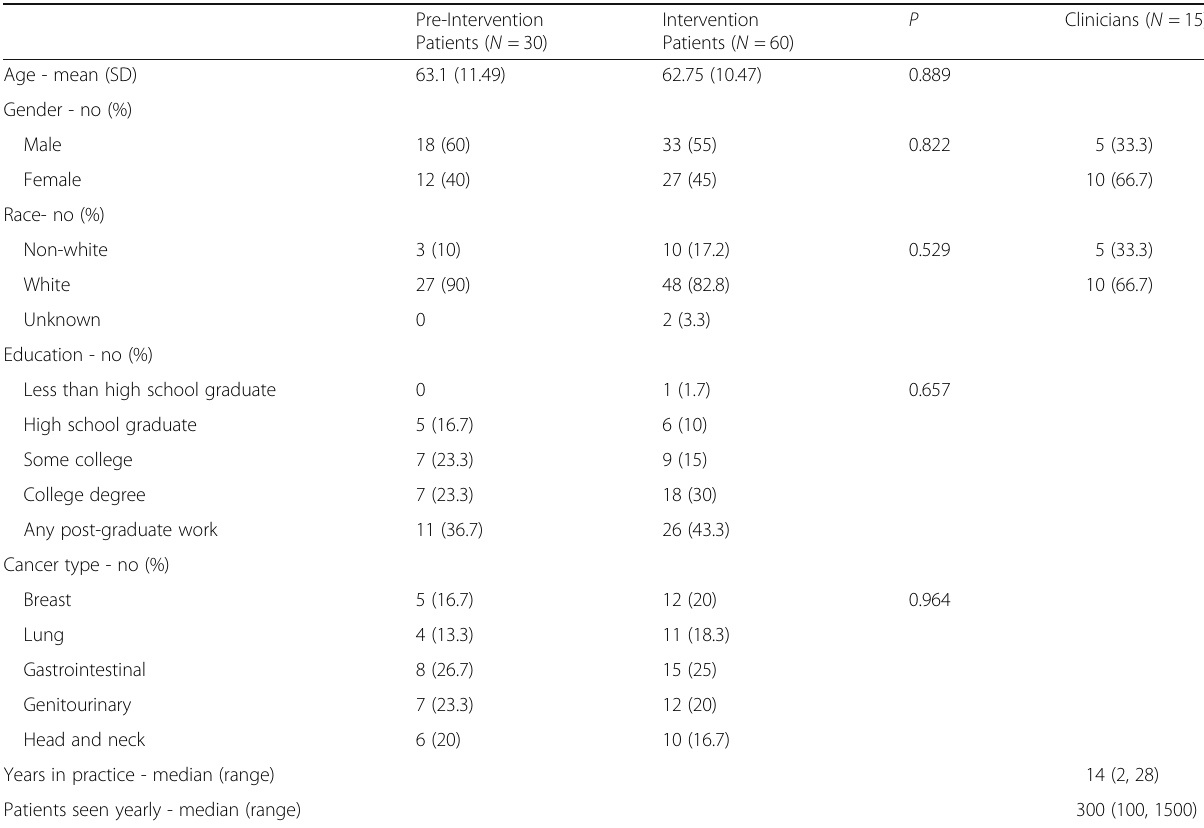
Table 1 Patient and Clinician Baseline Characteristics